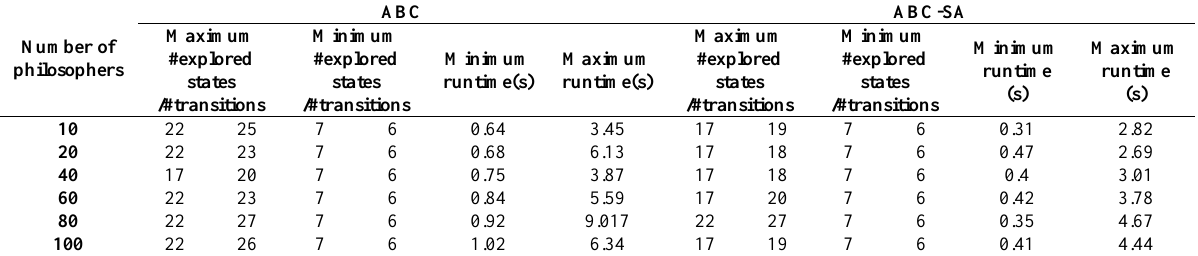
Table 6. Running details of the ABC and ABC-SA approaches in the dining philosophers’